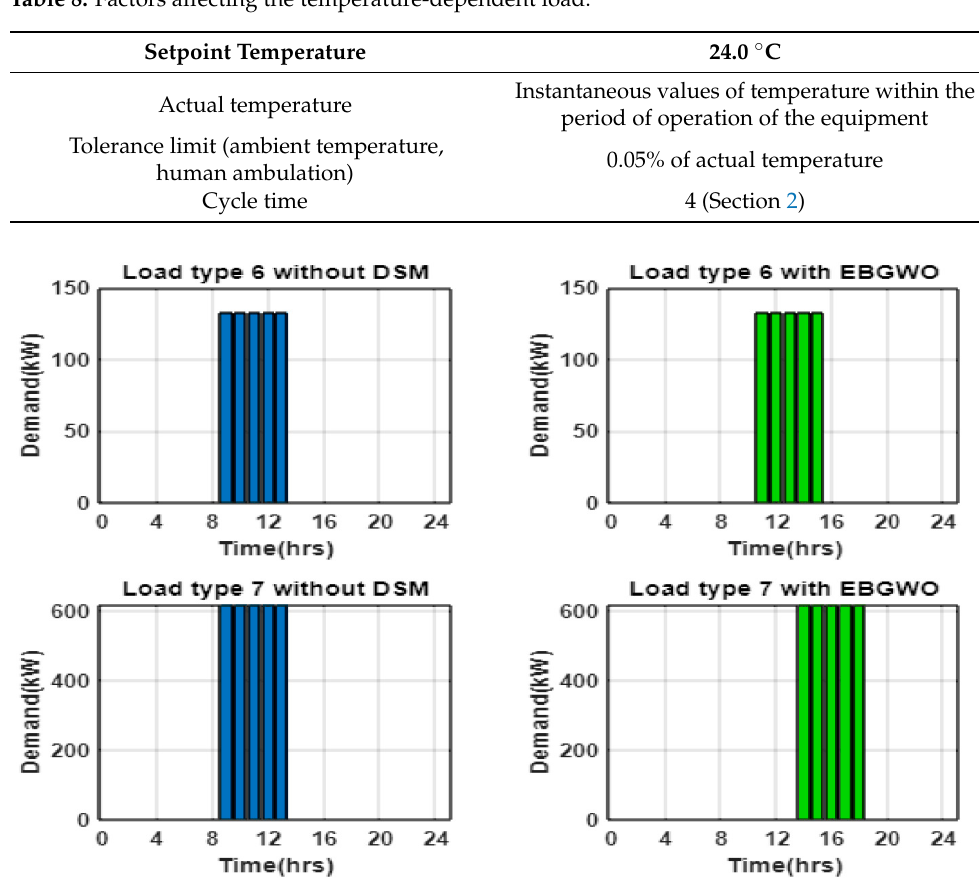
Table 8. Factors affecting the temperature-dependent load.